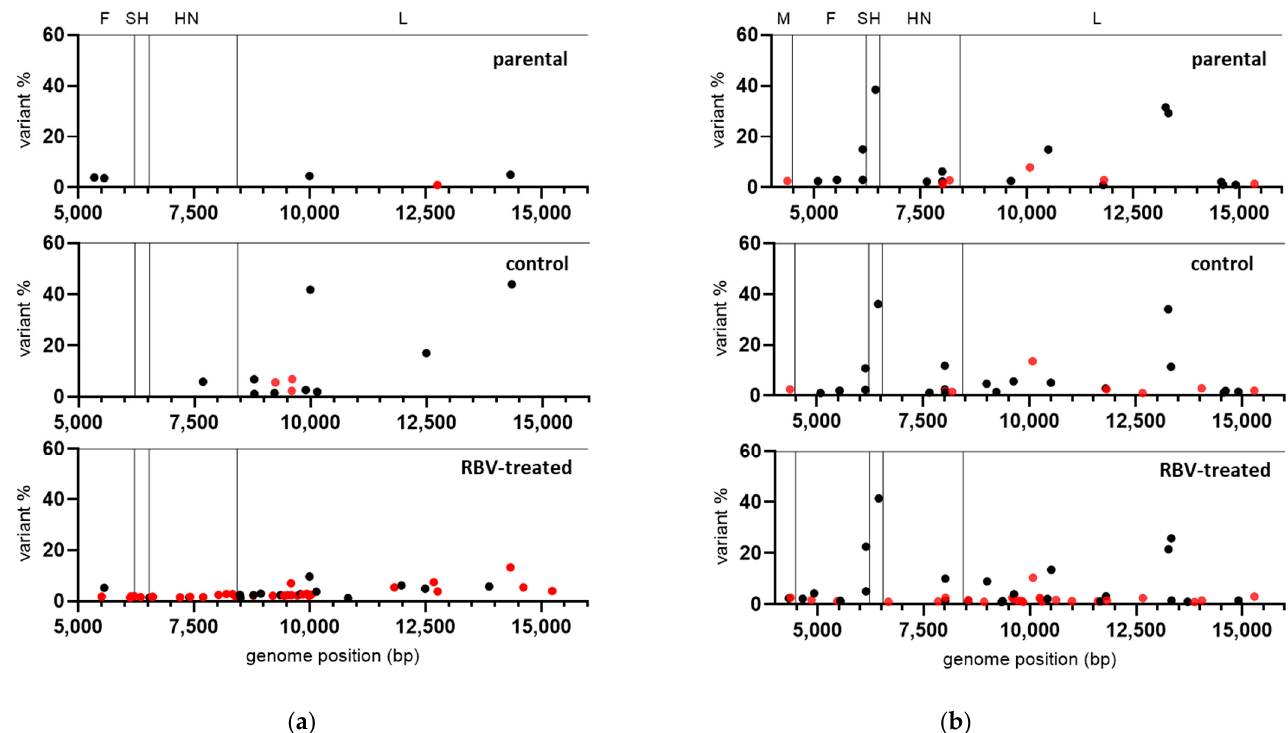
Figure 3. Variant frequency (%) in parental and RBV-treated (250 μ M) or control MuVi-C and ZgA/Cro69 viruses from the first passage in Vero and A549 cells, respectively, according to their location in the genome: ( a ) MuVi-C and ( b ) ZgA/Cro69. Corresponding genes are given at the top of the diagrams. RBV-specific mutations (G-to-A and C-to-U) are shown by red dots and all other mutation types by black dots. Only variants present at >1% are shown.